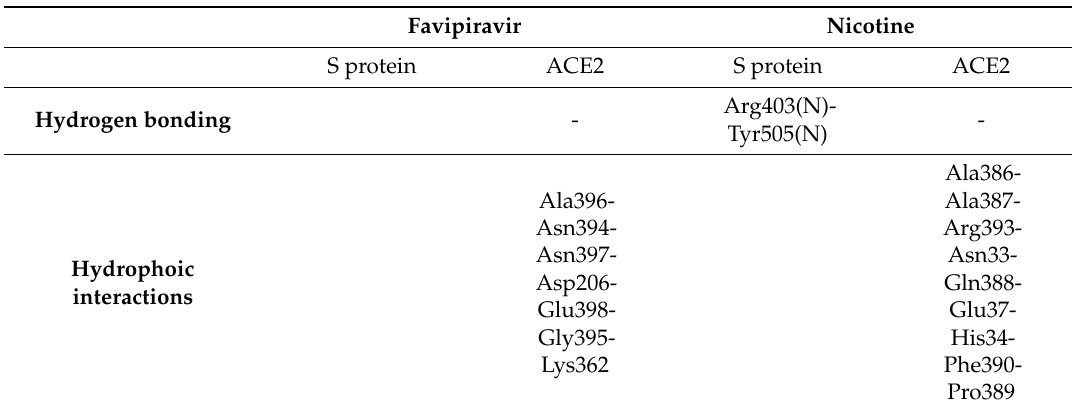
Table 1. Contact residues of the SARS-CoV-2 CTD-ACE2 interfacing with favipiravir and nicotine. The residues involved in the hydrogen and hydrophobic interactions between S protein and ACE2 with favipiravir + nicotine.